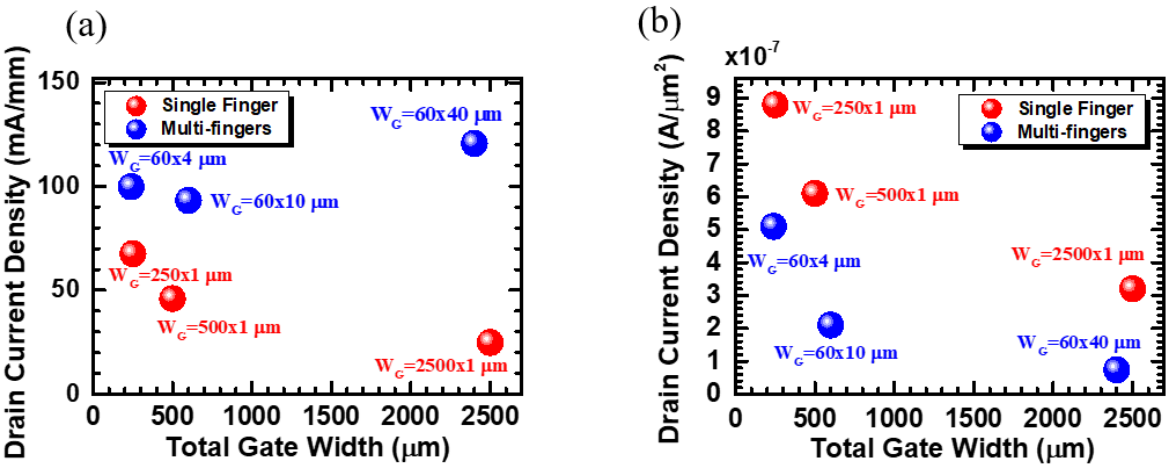
Figure 5. Drain current densities of p-GaN HEMTs with different total gate width. ( a ) Drain current density (normalized by W G ) versus total gate width. ( b ) Drain current density (normalized by active area) versus total gate width.